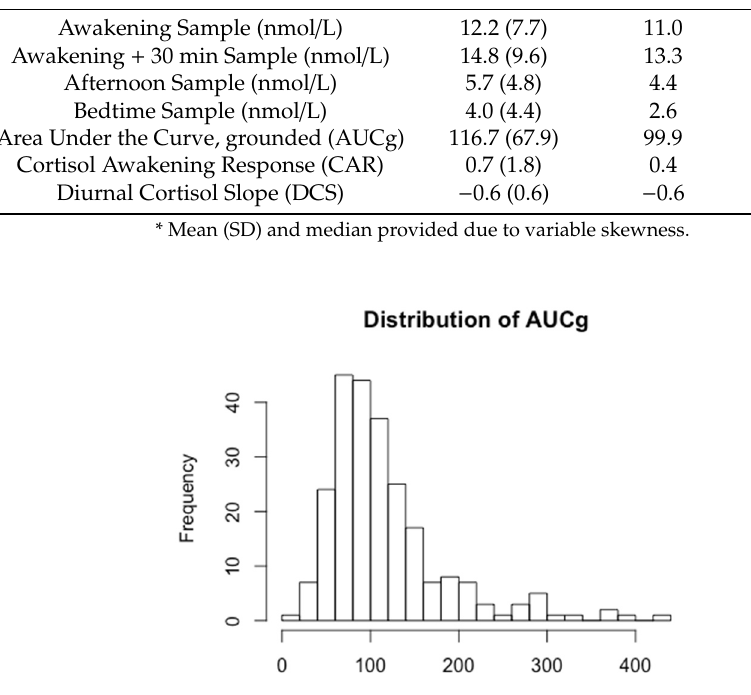
Figure 3. Area under the curve, grounded distribution.